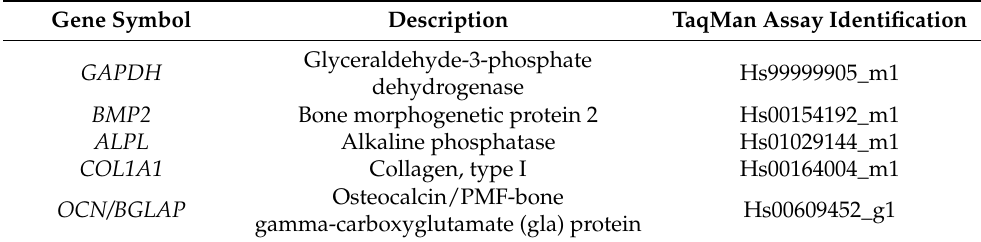
Table 1. Primers used for TaqMan gene expression